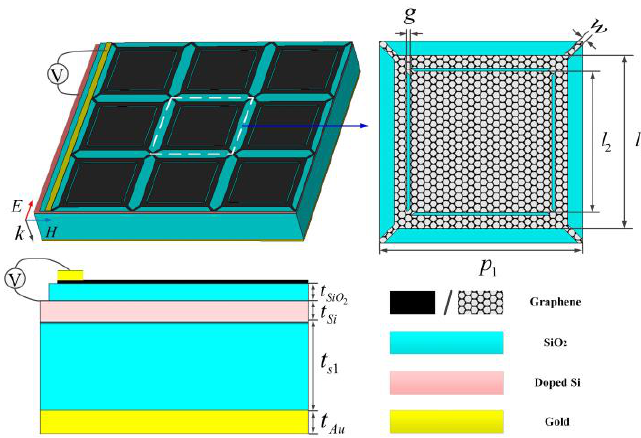
Figure 2. Schematic of the broadband absorption-controllable absorber. The values of the dimension parameters: p 1 = 70, l 1 = 60, l 2 = 49, g = 1, w = 2, t SiO